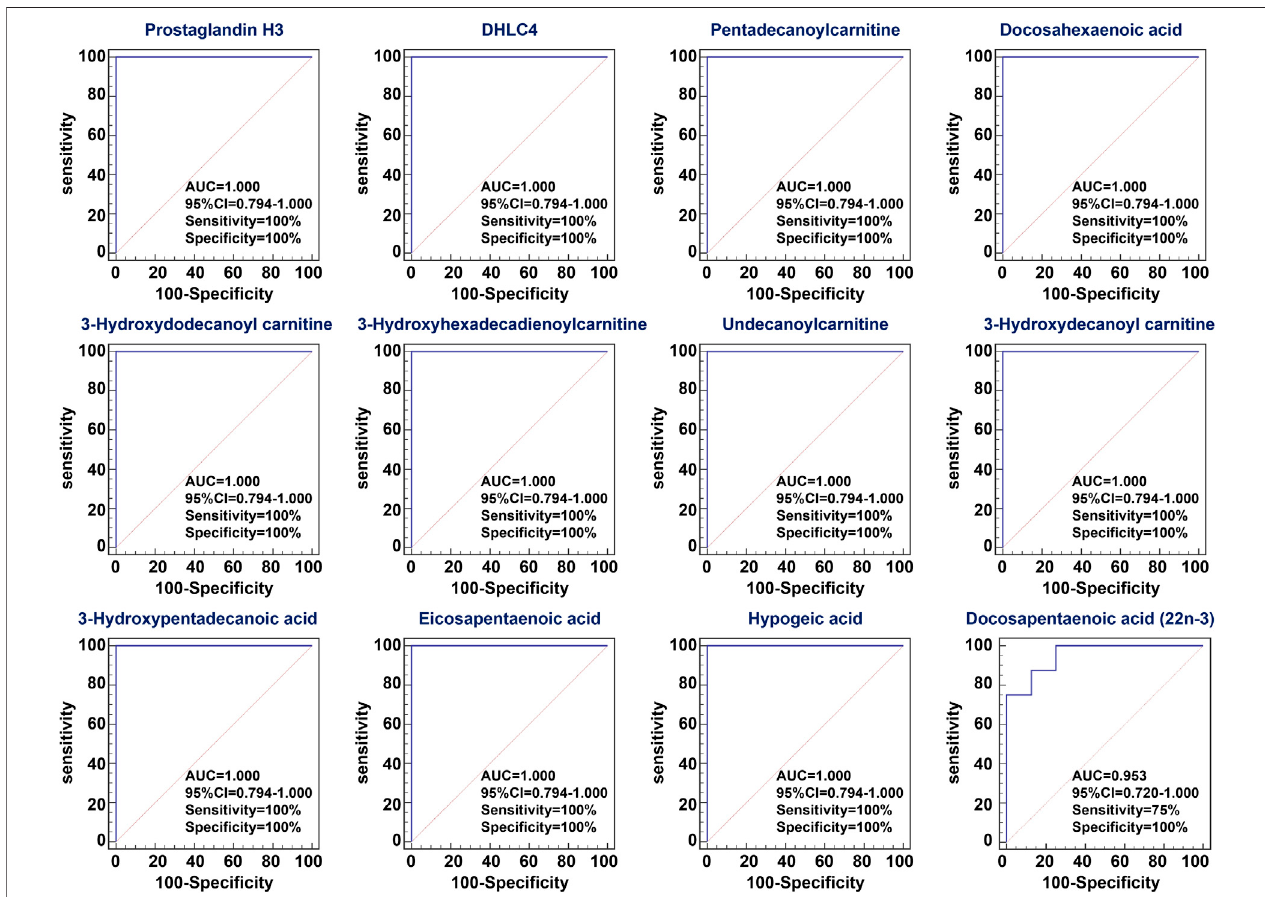
FIGURE 4 | ROC curve of differential lipid species. Analysis of PLS-DA based ROC curves of 12 lipid species in control and adenine-induced CRF groups. The associated AUC, 95% CI, sensitivity and speci fi city values were indicated.